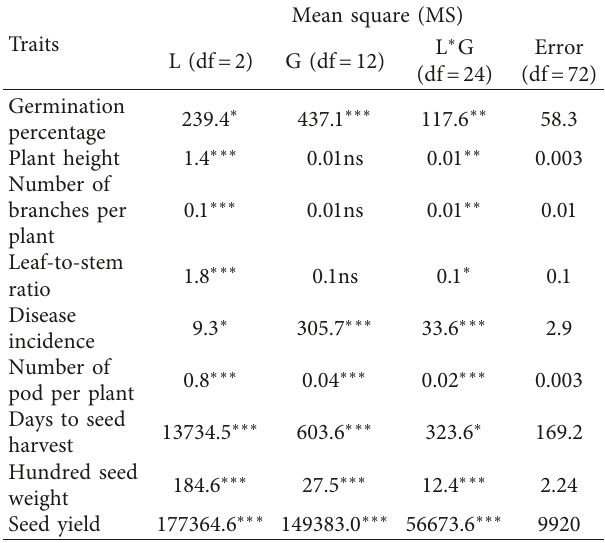
respectively. Table 11: Mean performance of different agronomic traits of Lablab purpureus at Tepi, Bechi, and Kite testing sites. Agronomic traits